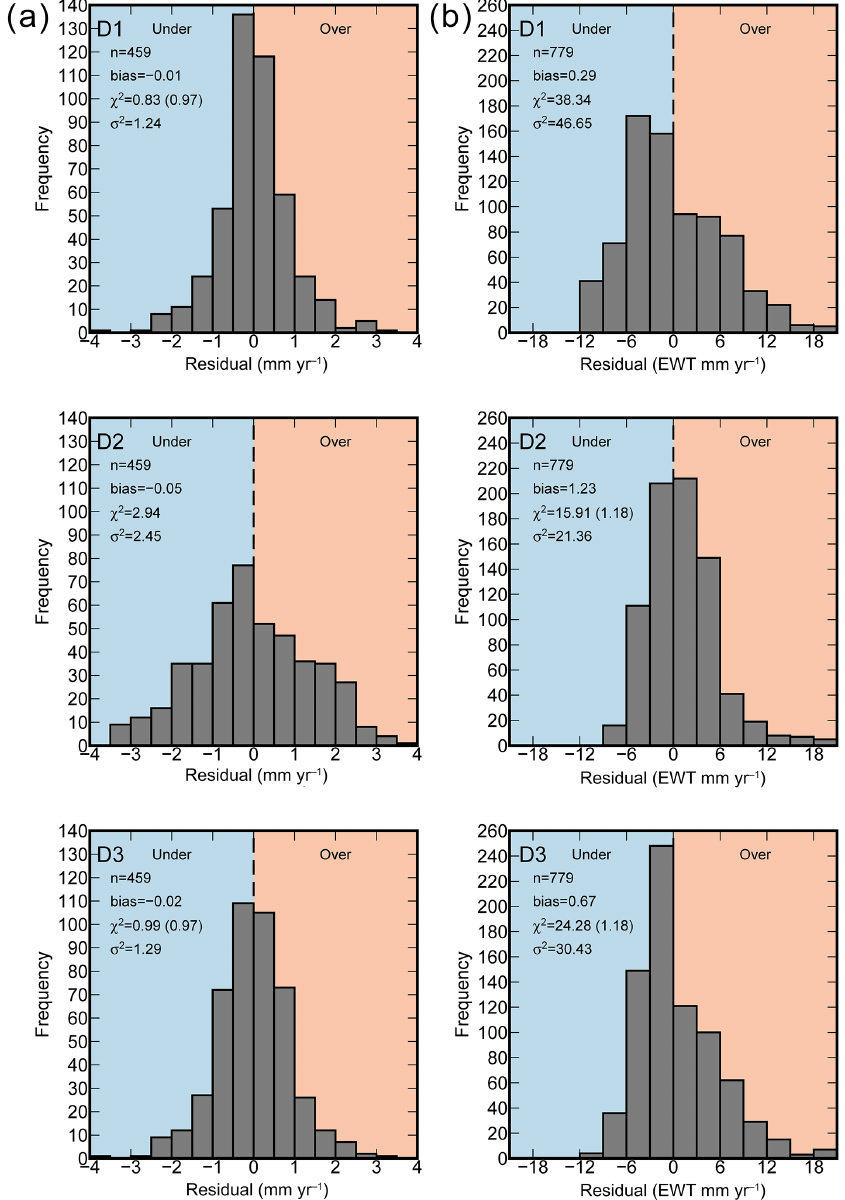
Figure 9. Histogram of residuals for models D1–D3, for prediction of vertical motion (a) and gravity change (b) . Pink and blue shading indicate model overprediction and underprediction, respectively. Where given, χ 2 values in brackets show the VCE-scaled χ 2